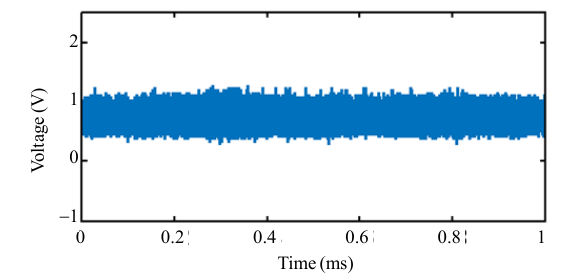
Fig. 5 Time-domain behavior of the